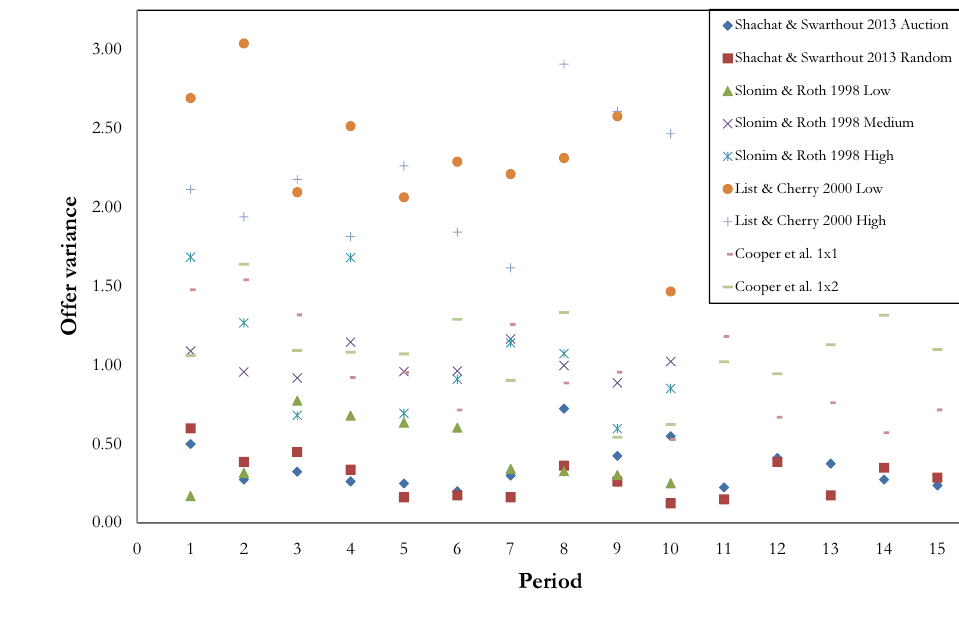
Figure 2. Within session offer variances across studies and